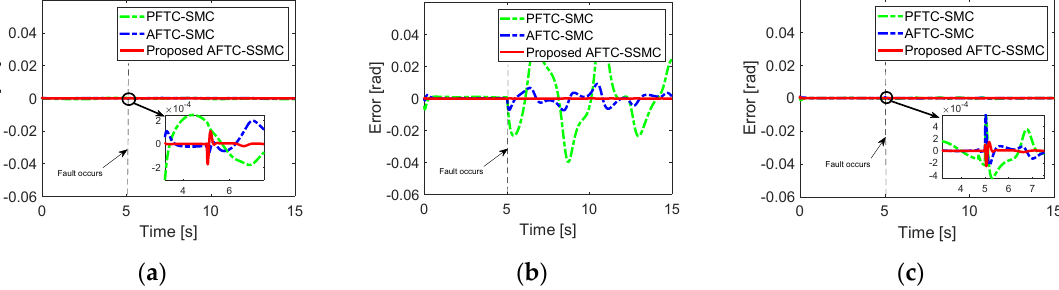
Figure 4. Tracking error at each joint in the simulation with a single fault at Joint 2. ( a ) Joint 1; ( b ) Joint 2; ( c ) Joint 3.